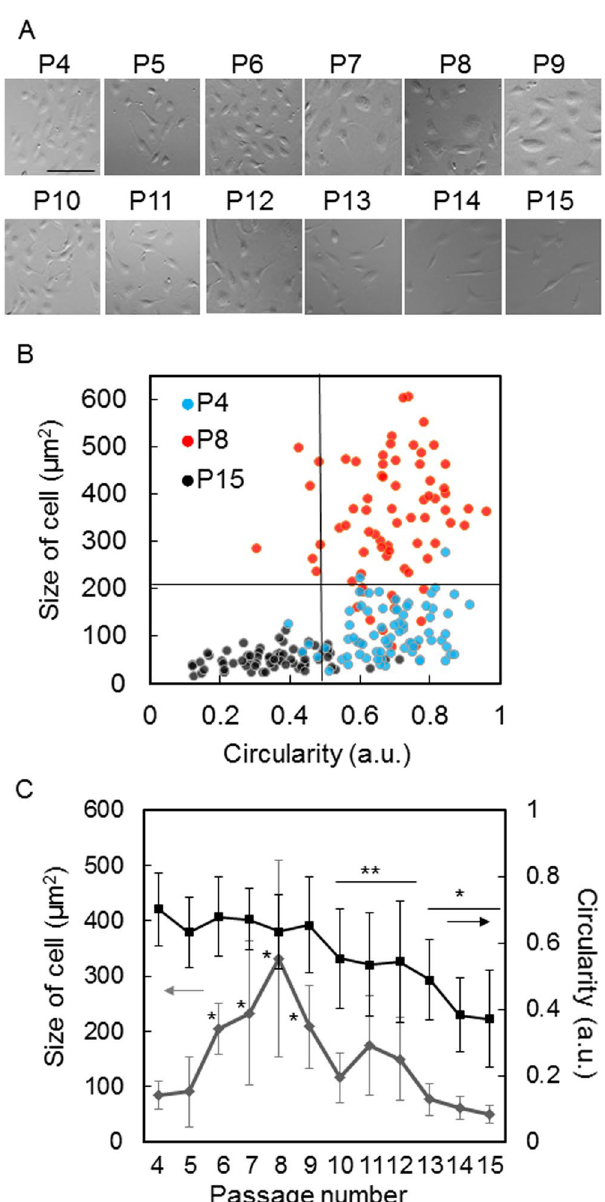
Figure 3. Morphological analysis of HUVECs at different passage numbers. ( A ) Morphology of HUVECs at passages 4 to 15. The images were taken with eRC-CMS at 48 hours of culture. The scale bar indicates 100 μ m. ( B ) Relationship between the size and circularity of cells at passages 4, 9, and 15. At least 30 cells were analysed at each passage. ( C ) Dependence of the size of cells and circularity on passage number. The values and error bars indicate averages and standard deviations calculated from these data of at least 30 cells for each passage number ( * p < 0.01, ** p < 0.05, compared to passage